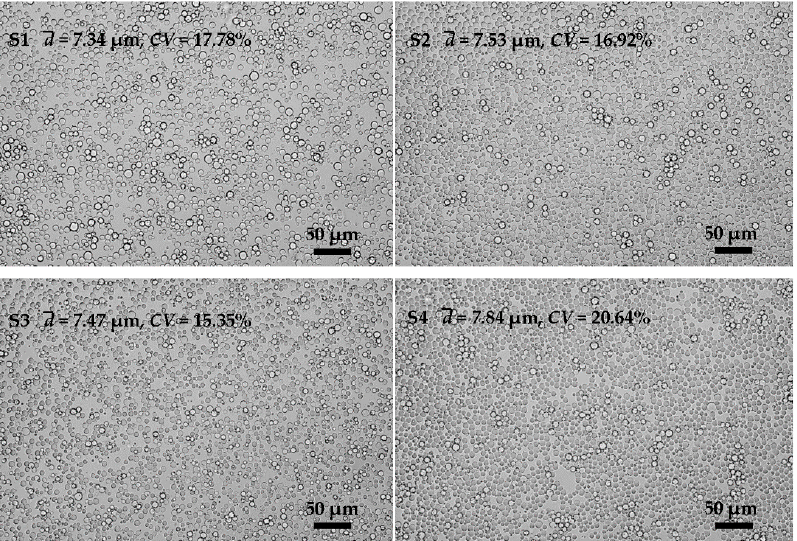
Figure 3. Microscopic photographs of KGM emulsions prepared with different emulsifier concentration (3%, 4%, 5% and 6%, Po-5S, w / w ). (3%, 4%, 5% and 6%, Po-5S, w / w